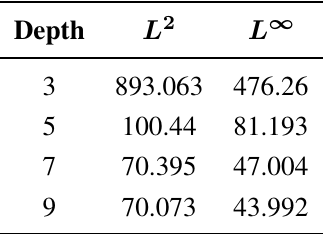
Table 1. Error (scaled by 10 − 5 ) of the computed solution of Poisson’s equation by Catmull–Clark subdivision on Disk 1 (see Figure 6), for different levels of subdivision when applying the Gauss quadrature. The subdivision is localized to not refine the overall